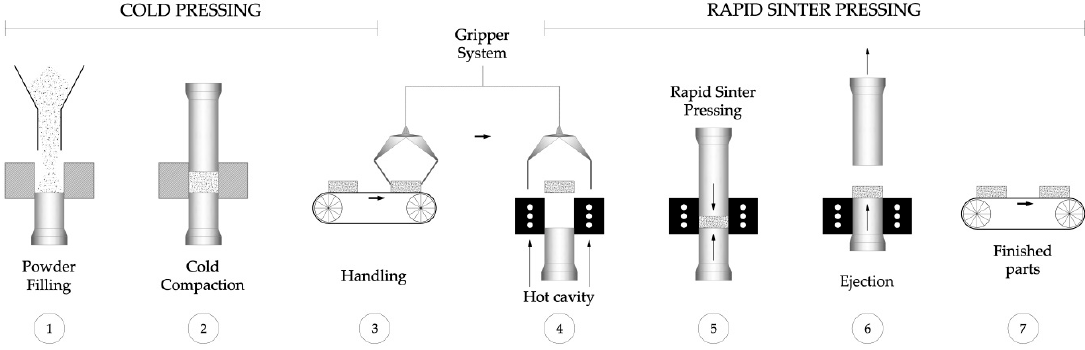
Figure 2. Scheme of the cold consolidation and the rapid sinter pressing processing of the W-Cu alloys.